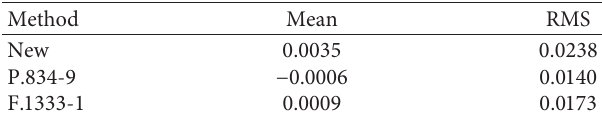
Table 6: Errors for an orbit of 36,000km for the winter high- latitude reference atmosphere when the apparent elevation angle is known (in degrees).